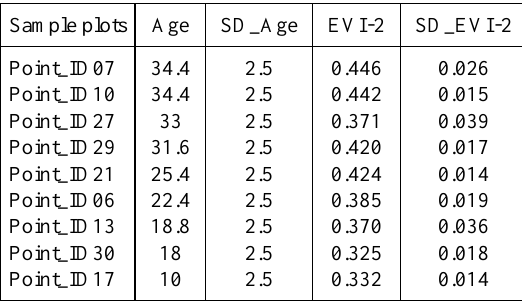
Table 2. Sample plot ID, age and EVI-2 values from a combined image from 2005 to